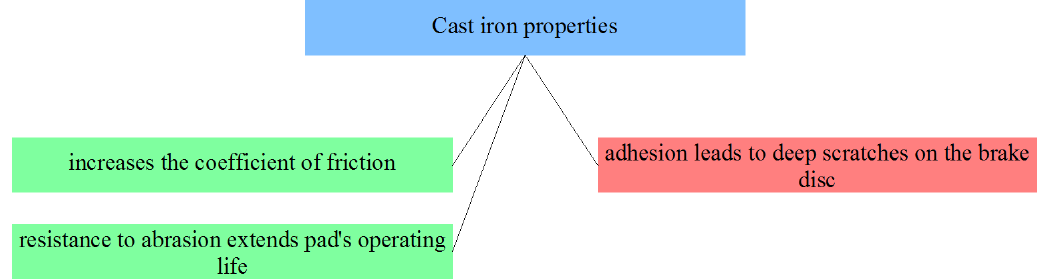
Figure 26: Selected cast iron composites properties from the point of view of applicability in friction materials